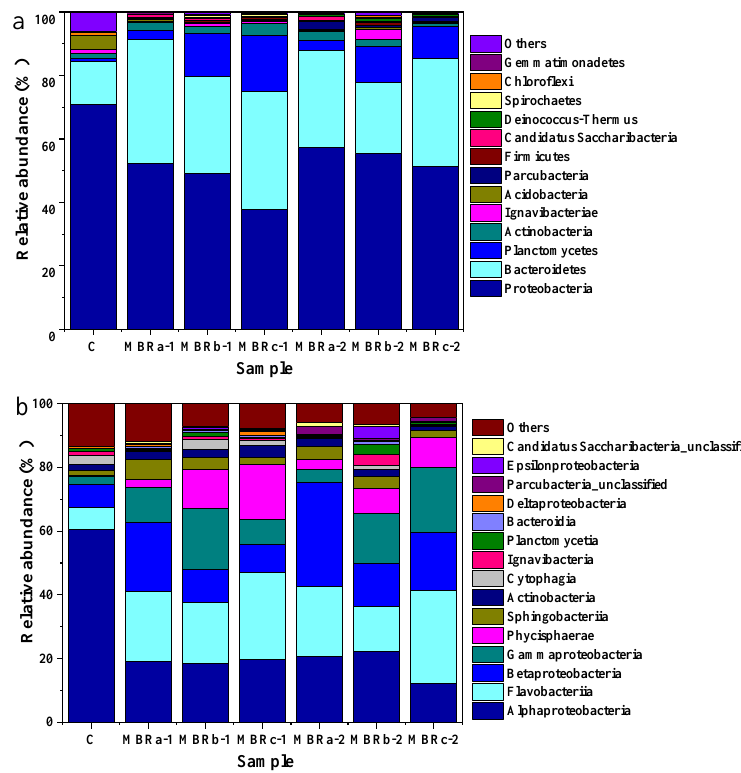
Figure 5. Microbial community structure in sludge samples in P0 (C) in MBRc, and P1 (MBRa-1, MBRb-1 and MBRc-1) and P2 (MBRa-2, MBRb-2 and MBRc-2). Results are shown at the ( a ) phylum level and ( b ) class levels.